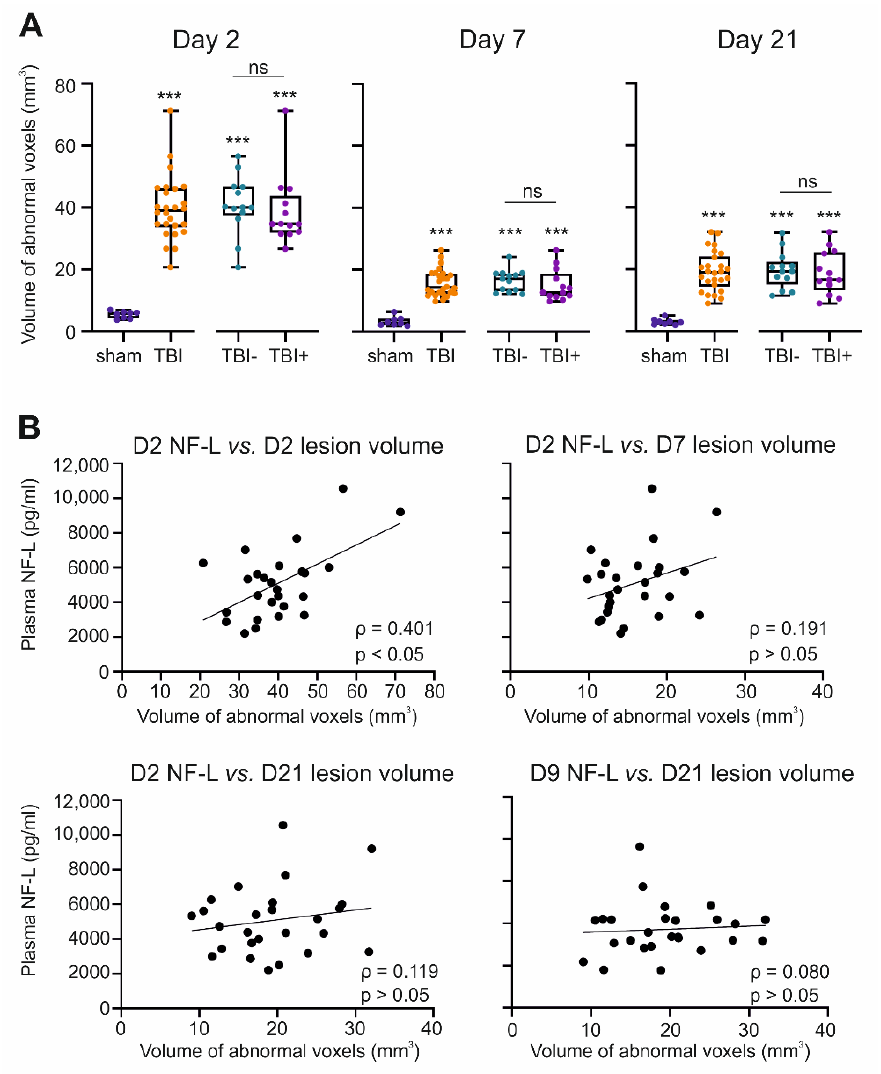
Figure 2. Plasma NF-L and cortical lesion severity in quantitative T 2 magnetic resonance imaging (MRI). ( A ) Box and whisker plots (whiskers: minimum and maximum; box: interquartile range; line: median) showing the total volume of abnormal pixels (cortical T 2 signal, y -axis) in rat brain MRI on D2, D7, and D21 after TBI (n = 26) or sham operation (n = 8). The TBI group included 13 rats without epilepsy (TBI − ) and 13 rats with epilepsy (TBI+). Each dot represents 1 animal. ( B ) Spearman correlation between the plasma levels of NF-L ( y -axis) and volume of abnormal T 2 area ( x -axis) in MRI (TBI group only) on D2, D7, and D21. Note that on D2, the higher the NF-L level, the greater the volume of the abnormal T 2 area. No correlations were detected at later time-points. Statistical significance: ***, p < 0.001 as compared with the sham group (Mann-Whitney U test). Abbreviations: D2, day 2 after TBI; D9, day 9; D21, day 21; NF-L, neurofilament light chain; ns, not significant; TBI, traumatic brain